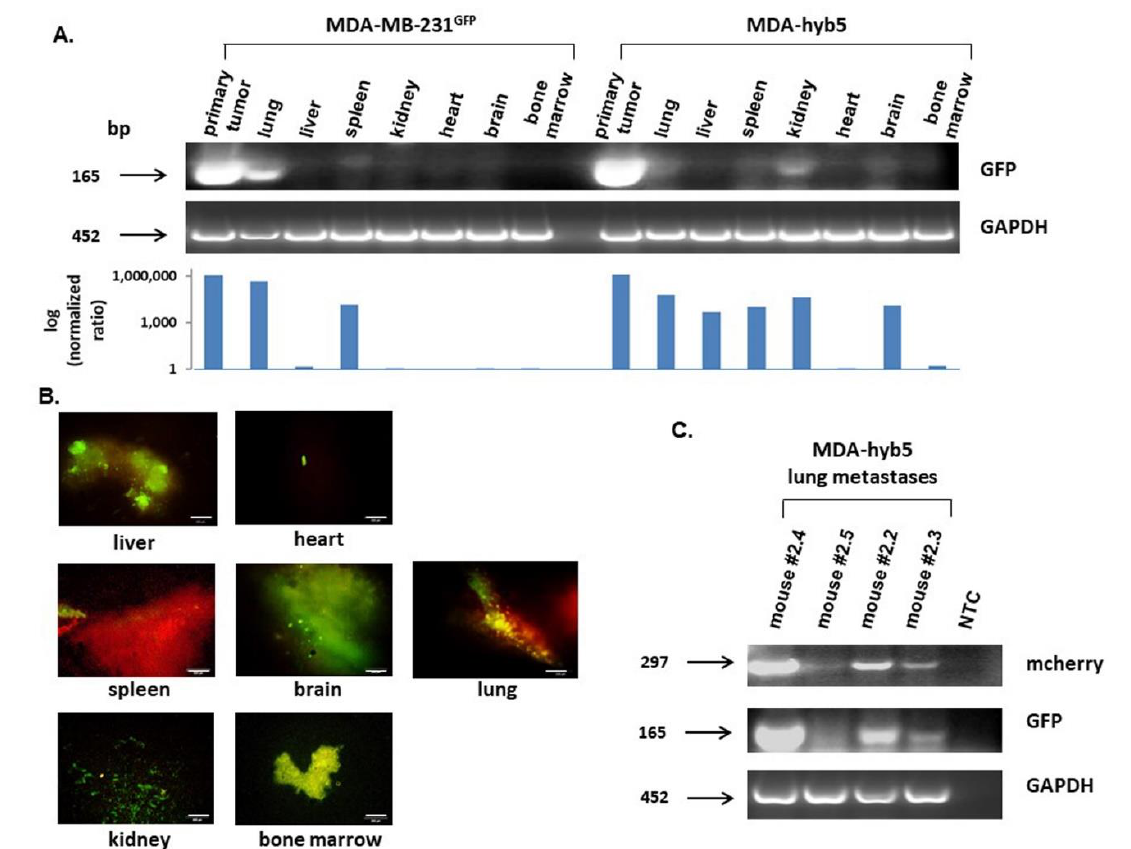
Figure 6. ( A ) Following the dissection of MDA-MB-231 GFP control cells- and MDA-hyb5 (mouse #2.5) cells-induced primary tumors and distal organ metastases including lung, liver, spleen, kidney, heart, brain, and bone marrow (prepared from femoral content), RNA aliquots were subjected to RT-PCR for GFP. GAPDH transcripts served as an equal loading control. Normalization of GFP expression levels by the corresponding GAPDH ratios was performed by densitometry scanning using the image J software. The resulting quantitatively comparable GFP expression levels in the different organs are demonstrated as a logarithmic bar diagram in the lower panel. ( B ) Distal organs and bone marrow from mouse #2.2 were dissected after euthanasia and evaluated by fluorescence microscopy, whereby appropriate fluorescence should indicate the formation of distant metastases. Bars represent 100 µm. ( C ) Aliquots of lung metastases from all four MDA-hyb5-induced mouse tumors, including a corresponding no template control (NTC), were subjected to RT-PCR for mcherry and GFP detection. GAPDH transcripts served as an equal loading control.